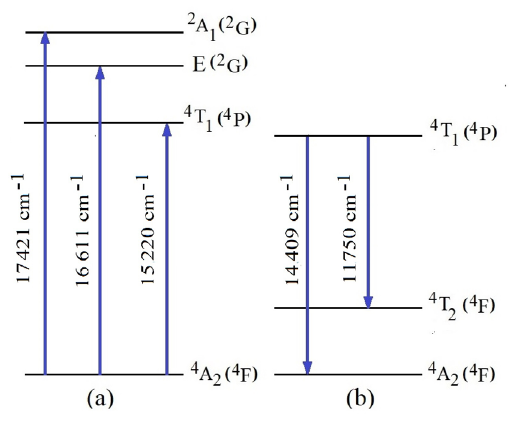
Figure 11. Energy levels and transitions of the Co 2+ ion in tetrahedral